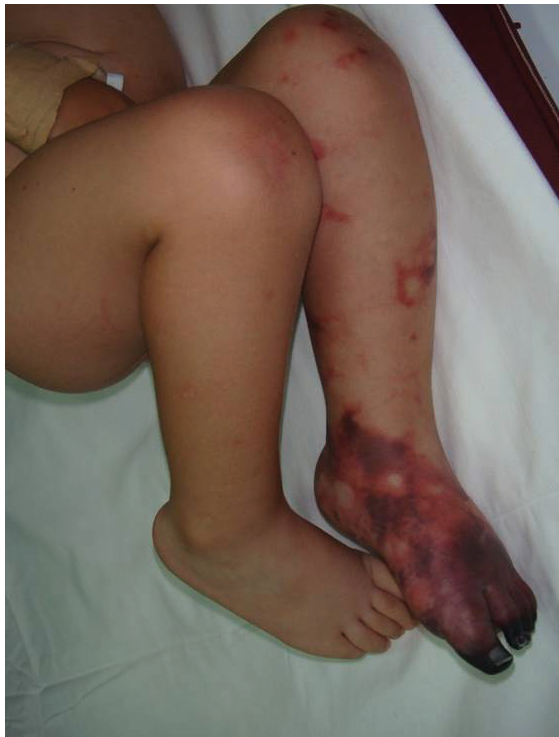
Figure 1. Livedo-like skin lesions below the knee; more condensed at the ankle and foot region with accompanying necrosis at the toes.